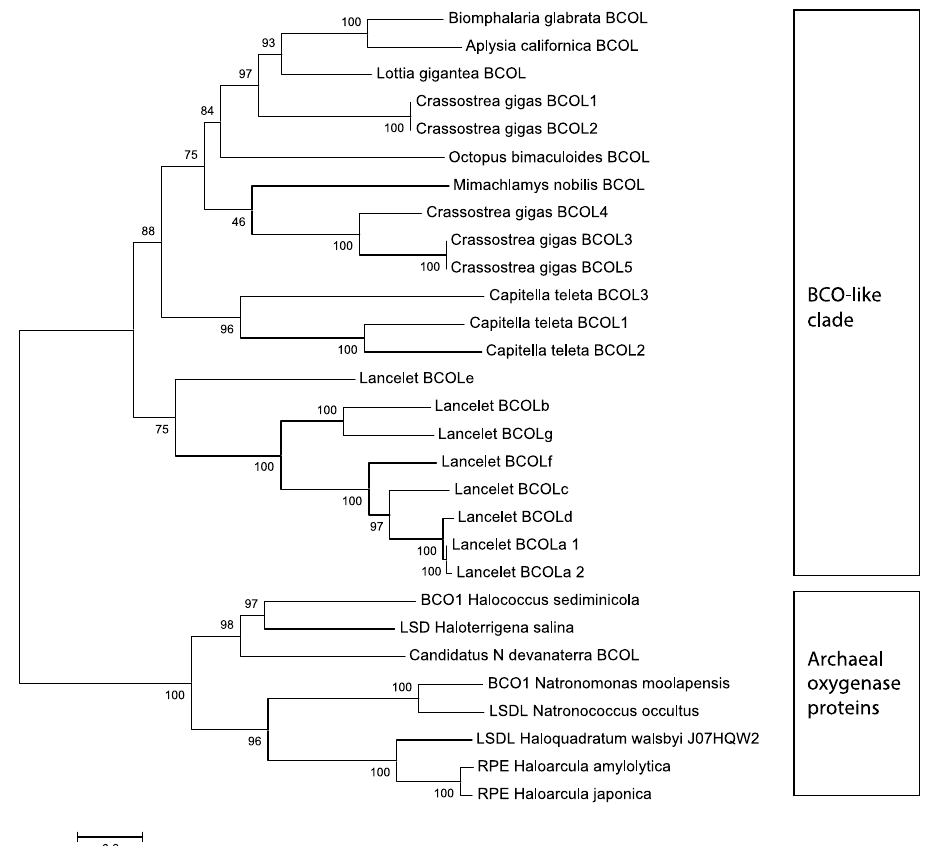
Figure 1. The phylogenetic tree of BCOL proteins. The phylogenetic tree of BCOL proteins was inferred by using the Maximum Likelihood method based on the WAG matrix-based model. Archaeal oxygenase proteins were used as an outgroup. The percentage of trees in which the associated taxa clustered together (bootstrap support values) is shown next to the branches. Initial tree(s) for the heuristic search were obtained automatically by applying Neighbor-Joining and BioNJ algorithms to a matrix of pairwise distances estimated using the WAG model, and then selecting the topology with superior log likelihood value. A discrete Gamma distribution was used to model evolutionary rate differences among sites (2 categories). The rate variation model allowed for some sites to be evolutionarily